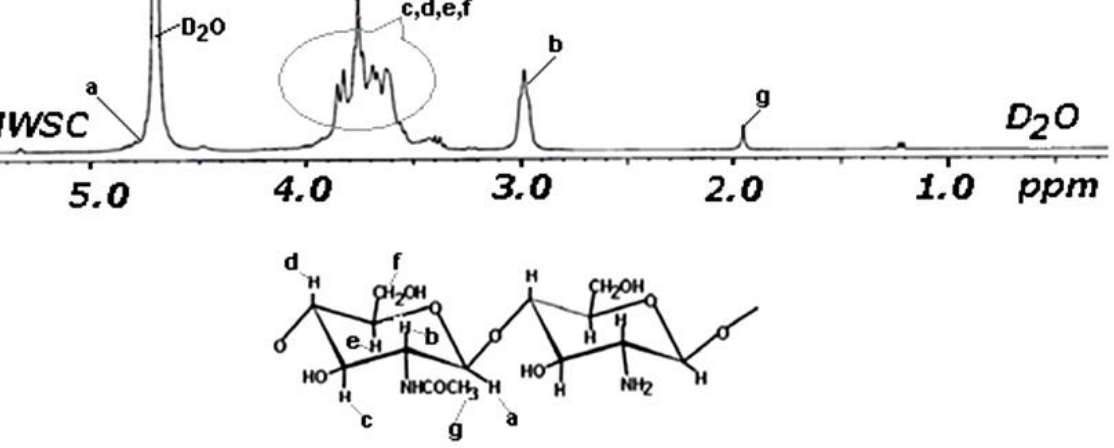
Figure 13. 1 H-NMR spectrum of low molecular weight water-soluble chitosan (LMWSC), adapted from [57].